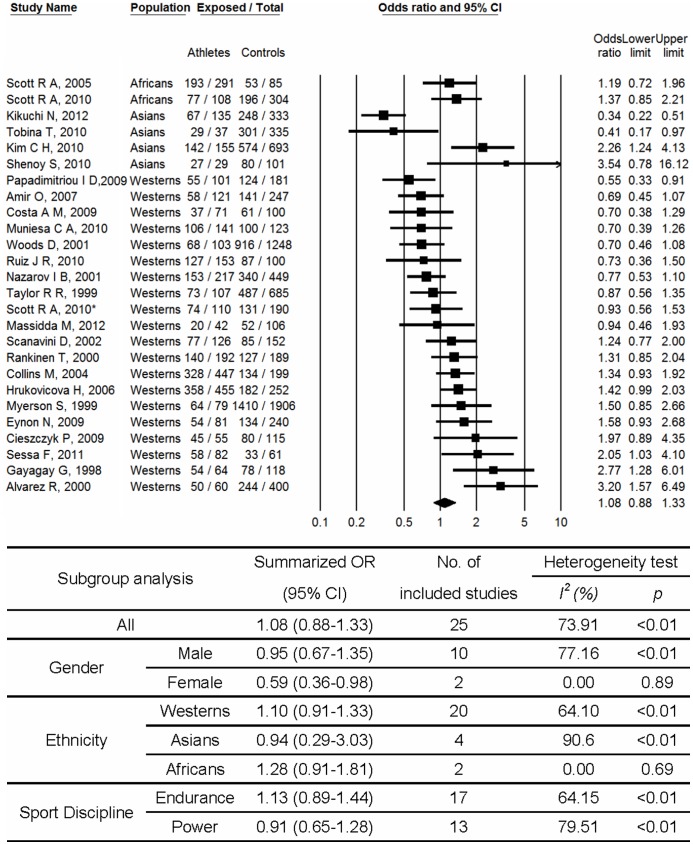
Meta-analysis of the association between sport performance and ACE polymorphism (II+ID vs. DD).Abbreviation: CI, confidence interval; OR, odds ratio. *Different study population from the same article.